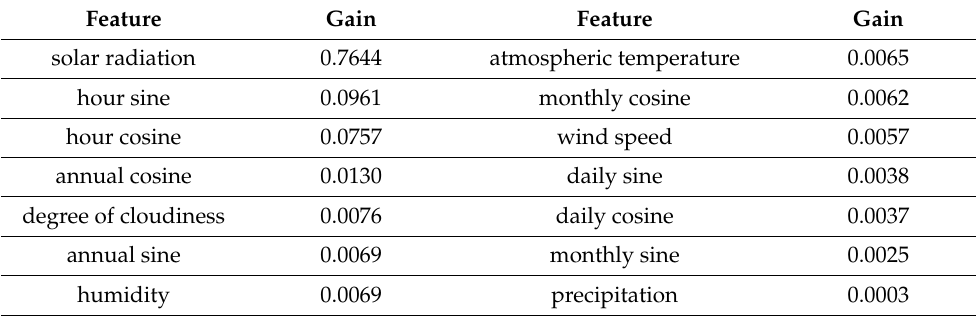
Table 2. Evaluating the importance of features using random forest.